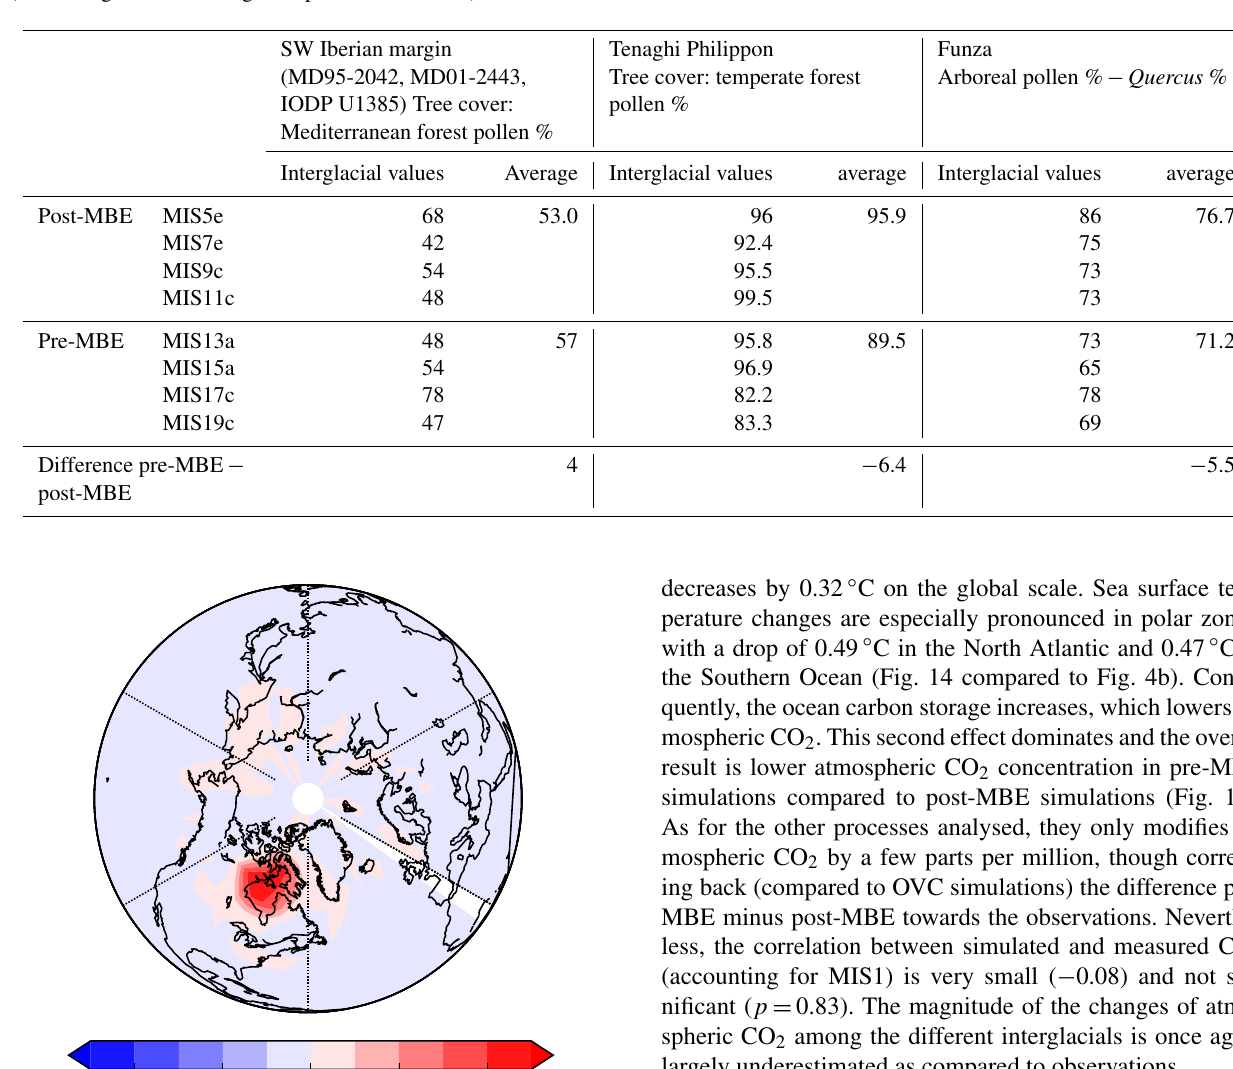
Table 4. Tree cover (%) reconstructed from pollen data at three sites. SW Iberian margin: MIS 5 (MD95-2042, Sanchez Goñi et al., 1999), MIS 7 (MD01-2443; Roucoux et al., 2006), MIS 9, 13, 15, 17 (IODP 1385, unpublished data), MIS 11 (U1385, Oliveira et al., 2016), MIS 19 (U1385, Sanchez Goñi et al., 2016); Tenaghi Philippon, Greece (Past Interglacials Working Group of PAGES, 2016); and Funza, Colombia (Past Interglacials Working Group of PAGES, 2016).